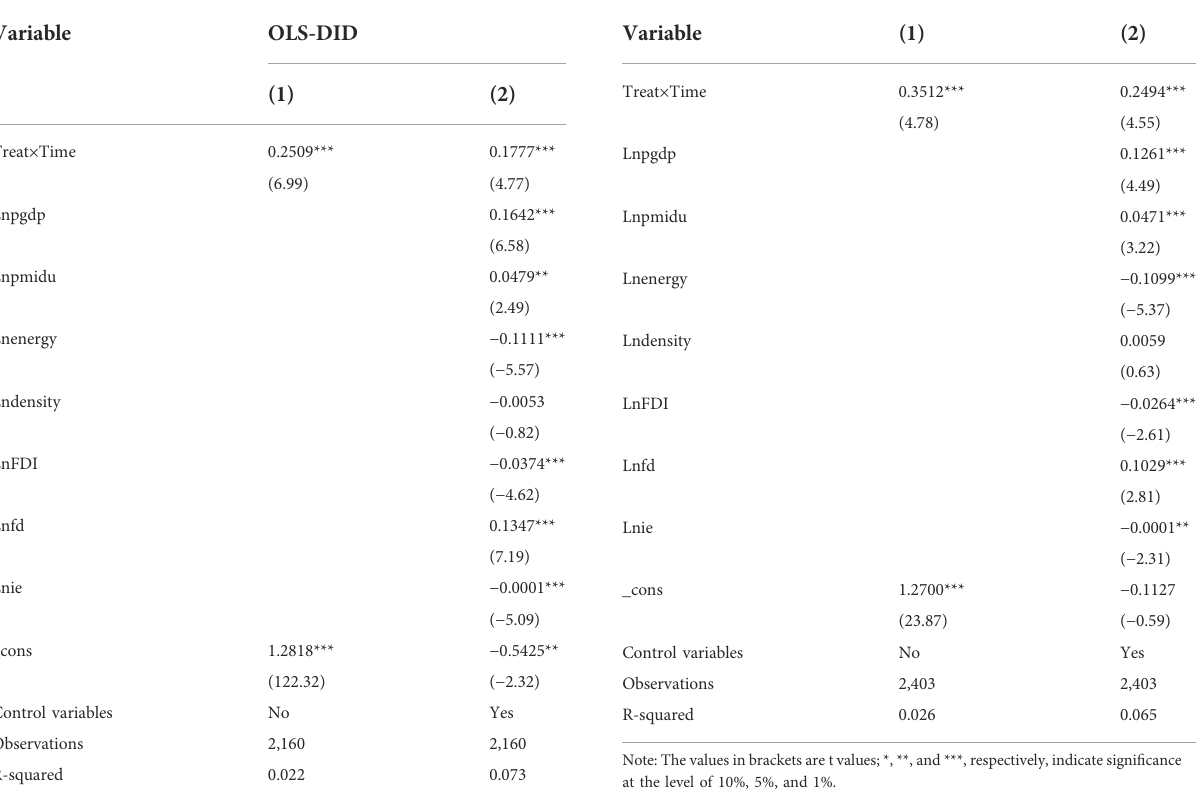
TABLE 7 Robustness test (PSM – DID).